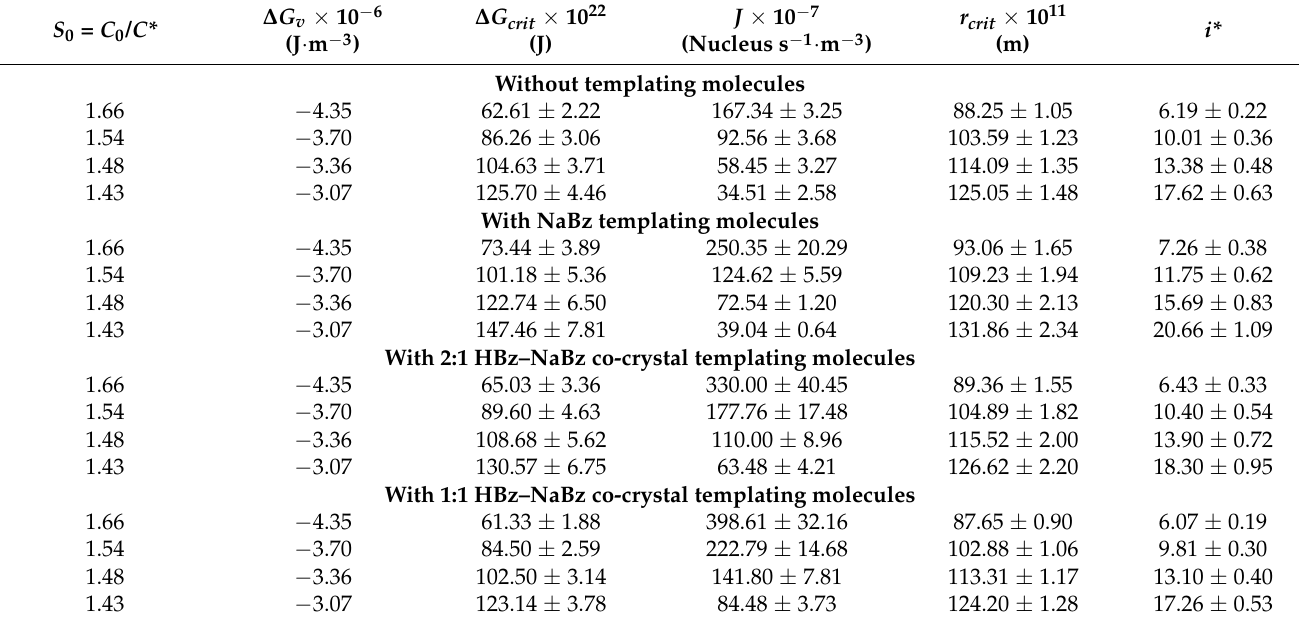
Table 2. Free energy change in transformation per unit volume ( ∆ G v ), free energy required to form a critical nucleus size ( ∆ G crit ), nucleation rate ( J ), critical nucleus size ( r crit ), and theoretical number of molecules in the critical nucleus ( i* ) of co-crystallization of 2:1 HBz–NaBz co-crystals at different initial degrees of supersaturation ( S 0 ) with and without templating